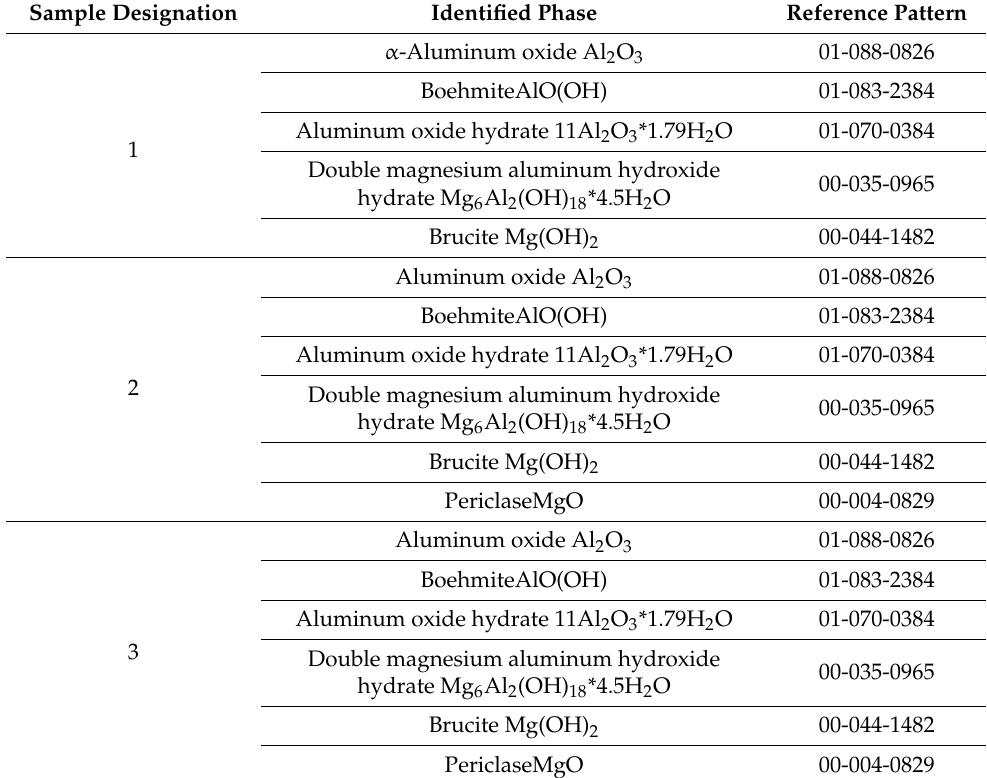
Table 2. Phase composition of the studied